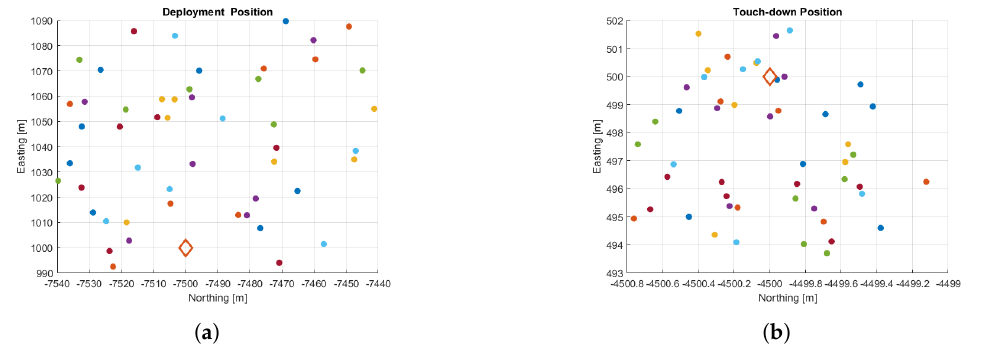
Figure 20. Deployment and touch down positions of the set of trajectories in Figure 19. The diamond shape indicates the nominal expected positions at deployment and at touch down. The colours for the deployment and the touchdown points are the same as their related trajectory in Figure 19. However, they are not relevant to the dispersion analysis. ( a ) deployment point; ( b ) touch–down